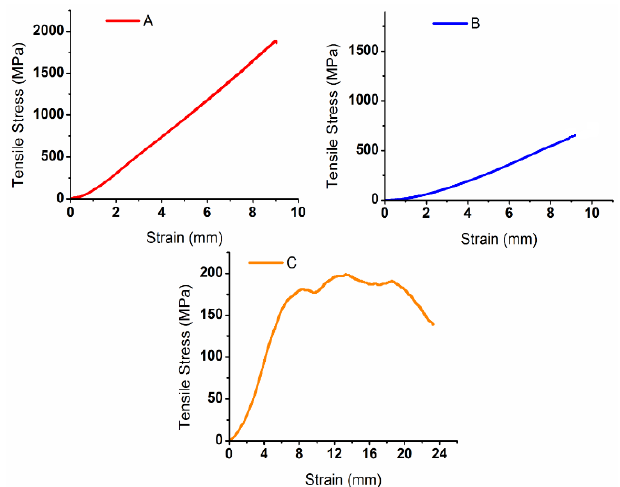
Figure 5. Tensile test results of each configuration: A, B, and C.